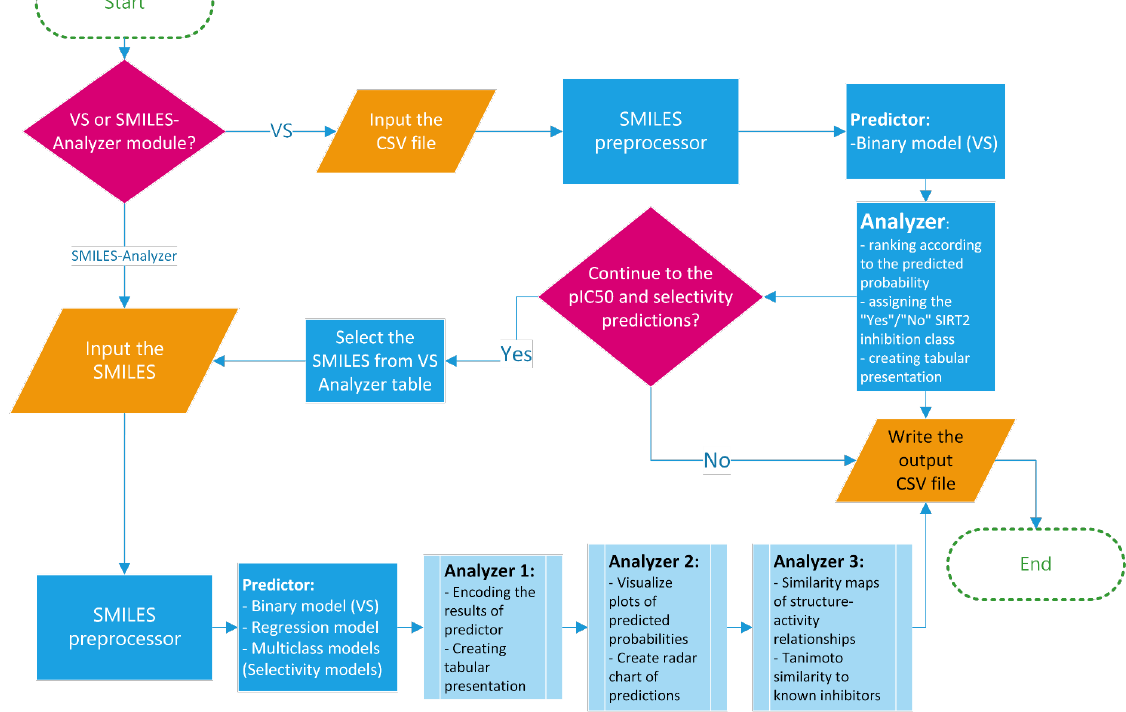
Figure 7. SIRT2i_Predictor framework.